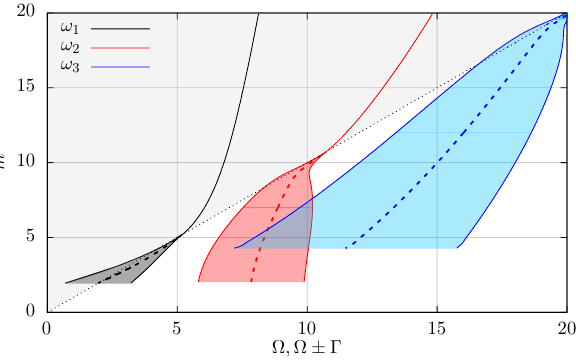
Figure 8 . Resonance modes for the unbinding potential with (cid:11) = 0 :